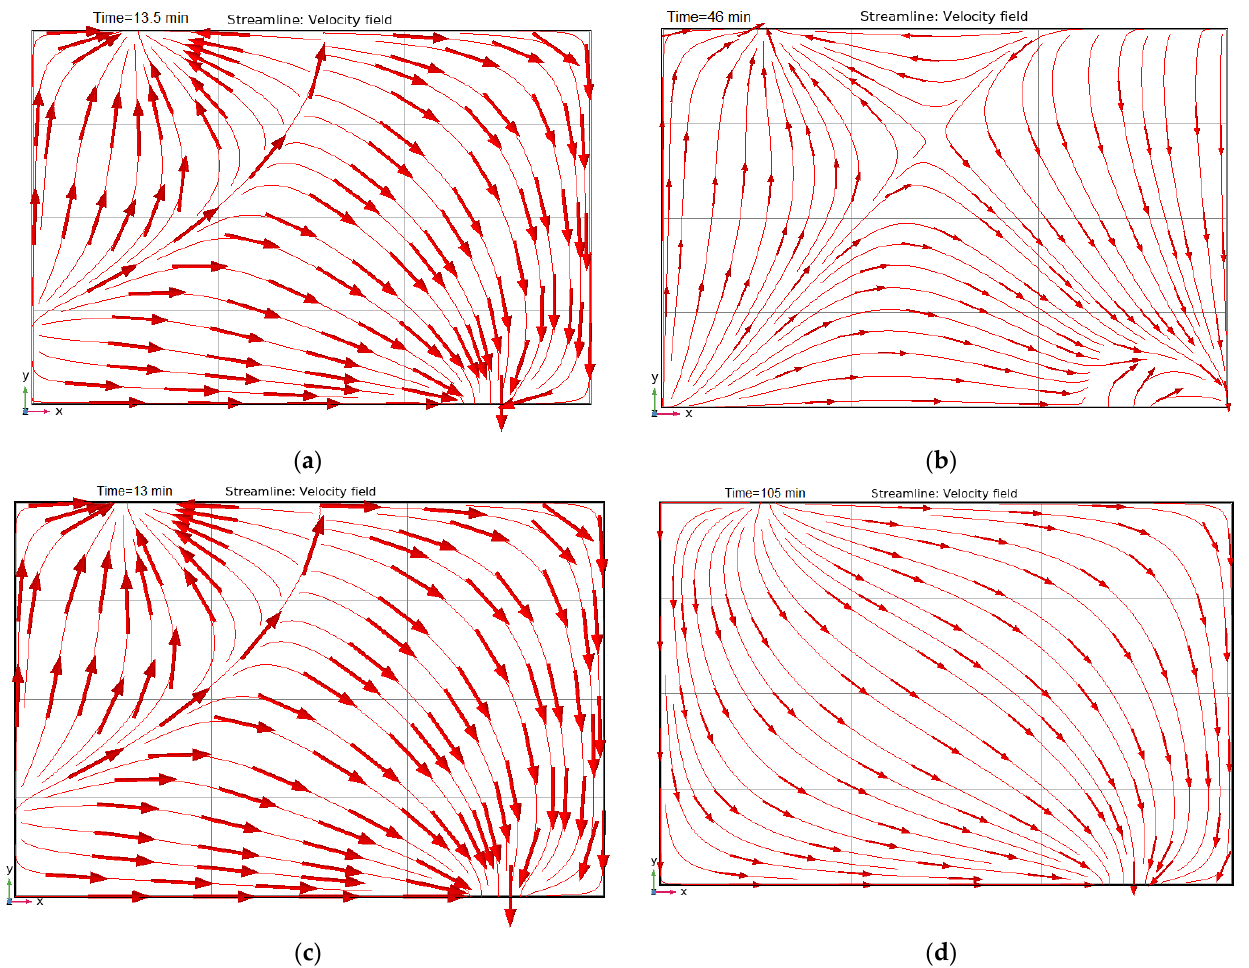
Figure 12. Maps of the resin streamlines in the preform under post-infusion application of external pressure according to the 1st scenario: ( a , b ) delay in the growth of the output pressure of 30 min; ( c , d ) without increase in outlet pressure (see Figure 11).